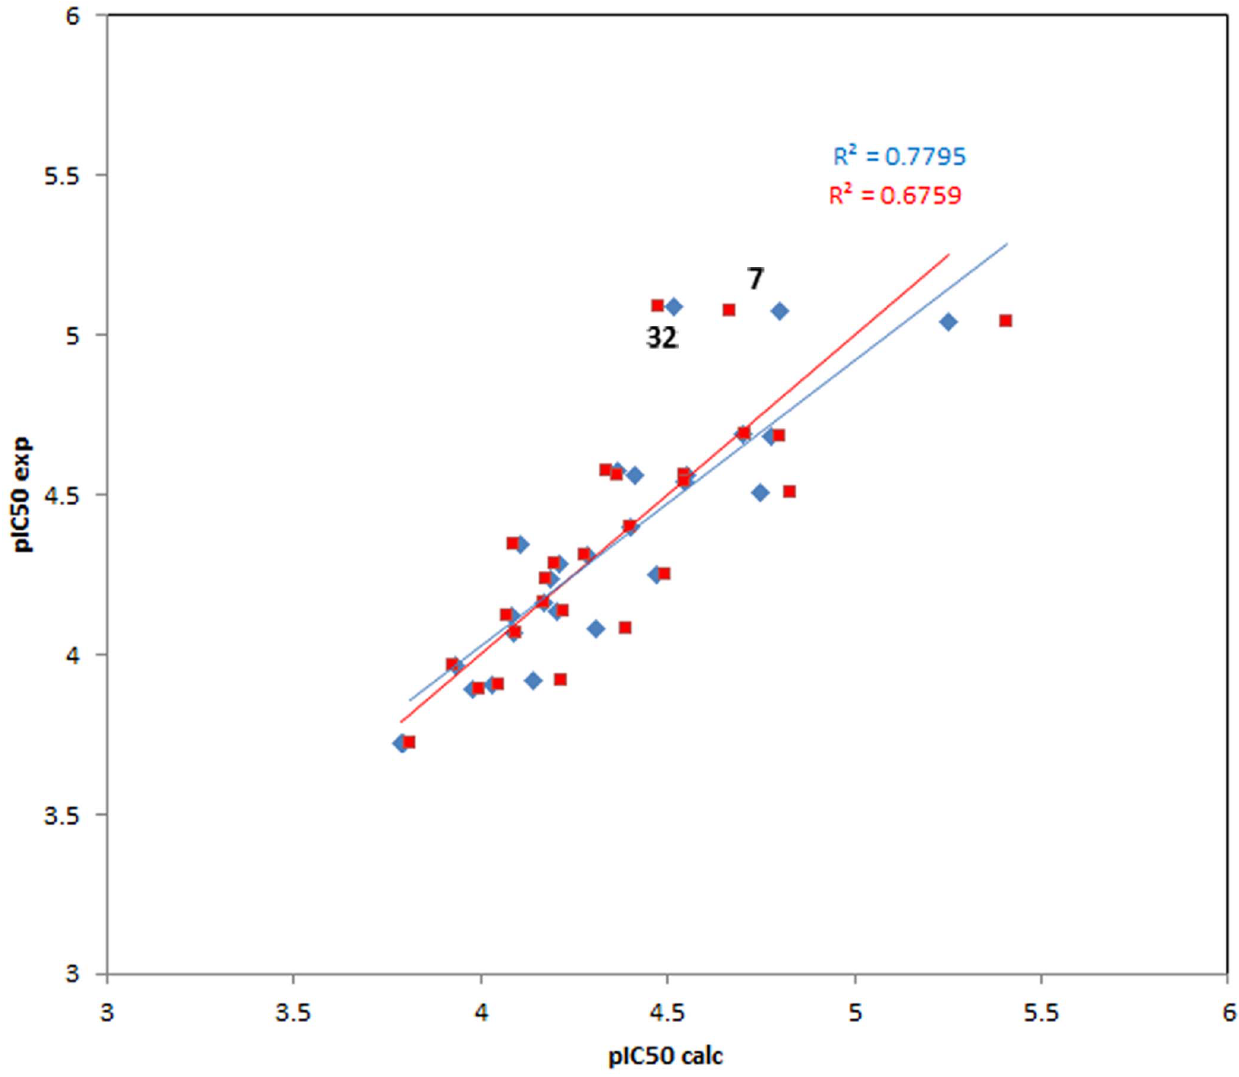
Figure 2. Plot of experimental pIC 50 values vs. values calculated by QSAR equation (1). Blue rhombi: calibration data, red squares: leave one out cross validation predictions. Highlighted by ellipse: Data points for compounds 7 and 32 which are not well explained by the equation.